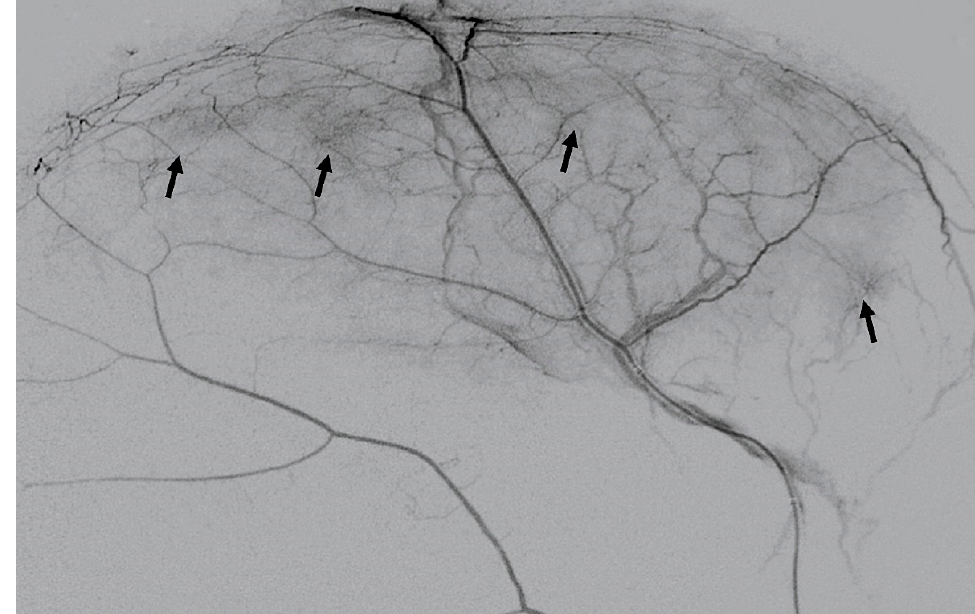
Figure 2. DSA, lateral view of a selective contrast medium injection of the MMA. Note the typical hypervascular areas (arrows).